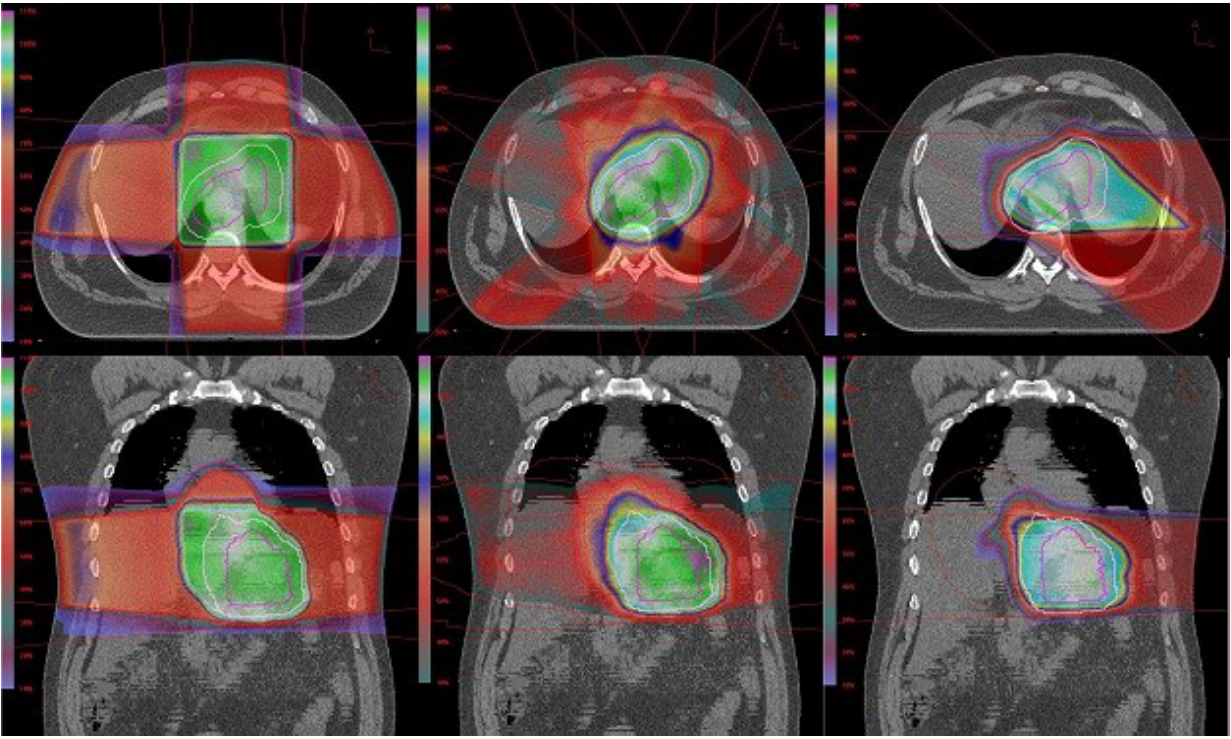
Figure 2. Coronal and transverse images of 3D-CRT plan (left), IMRT plan (middle), proton plan